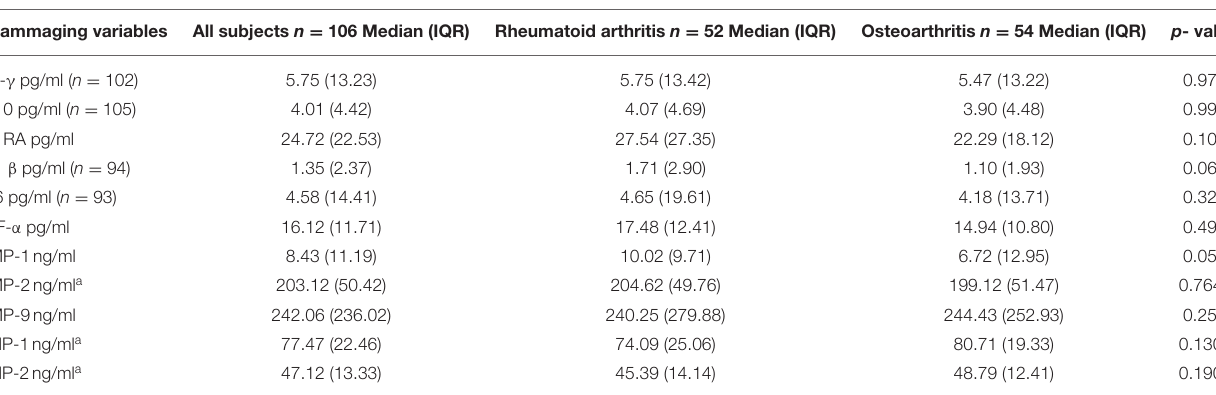
TABLE 6 | Inflammaging variables.